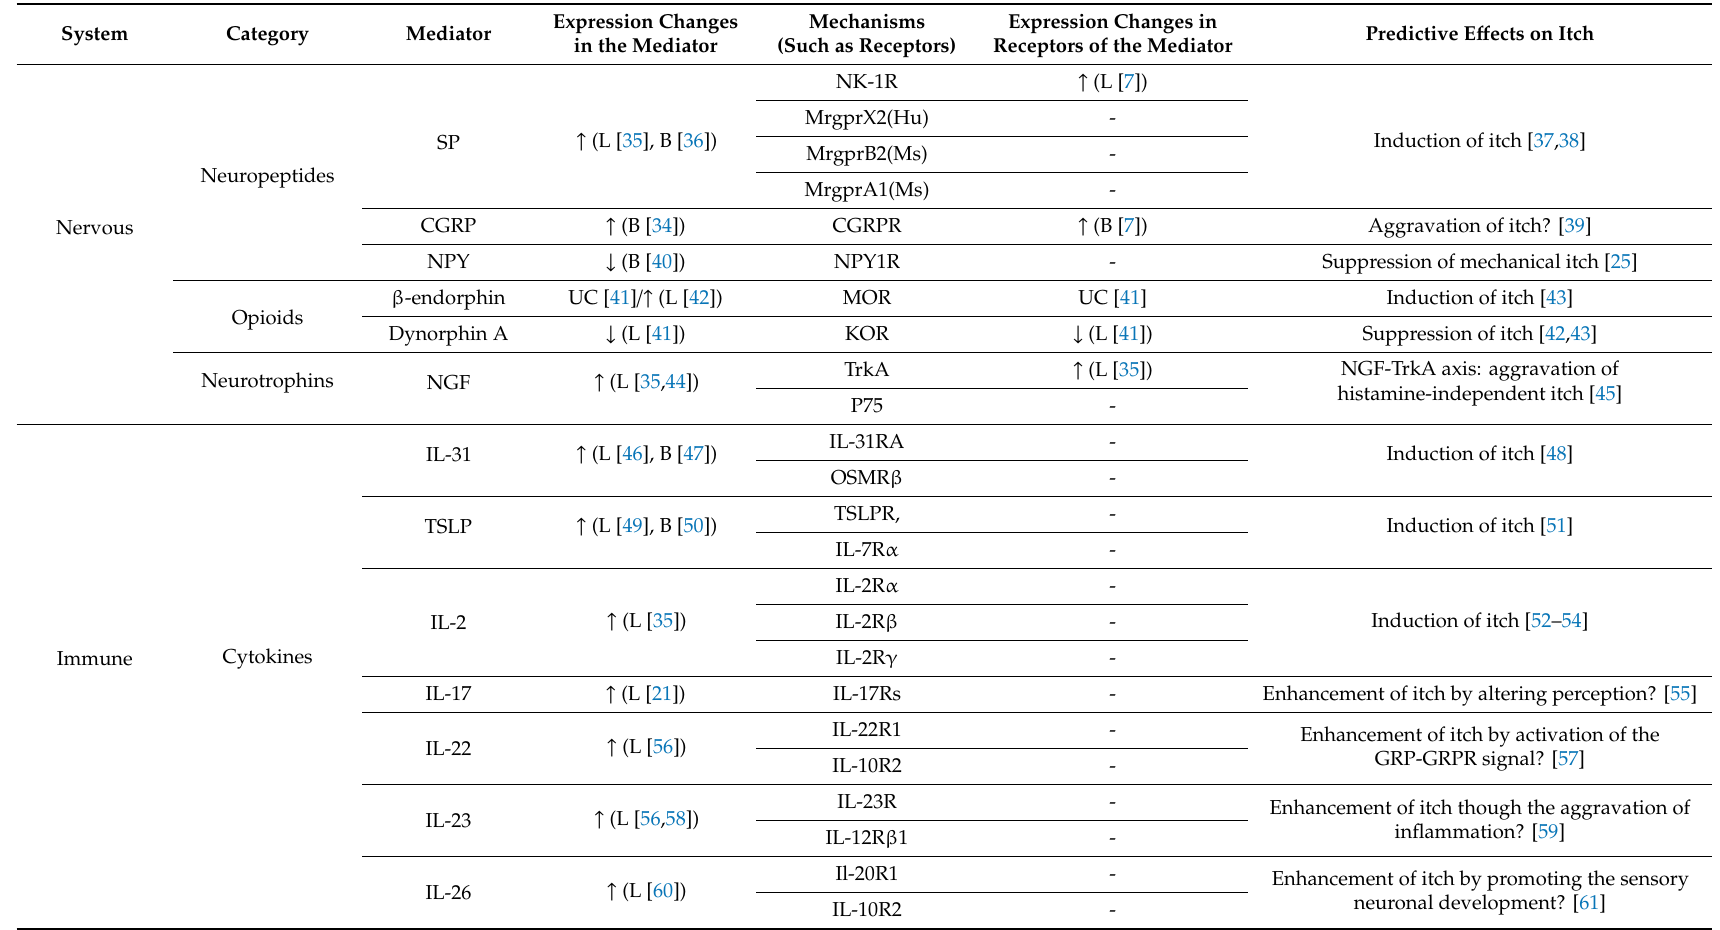
Table 1. Potential mediators of itch in